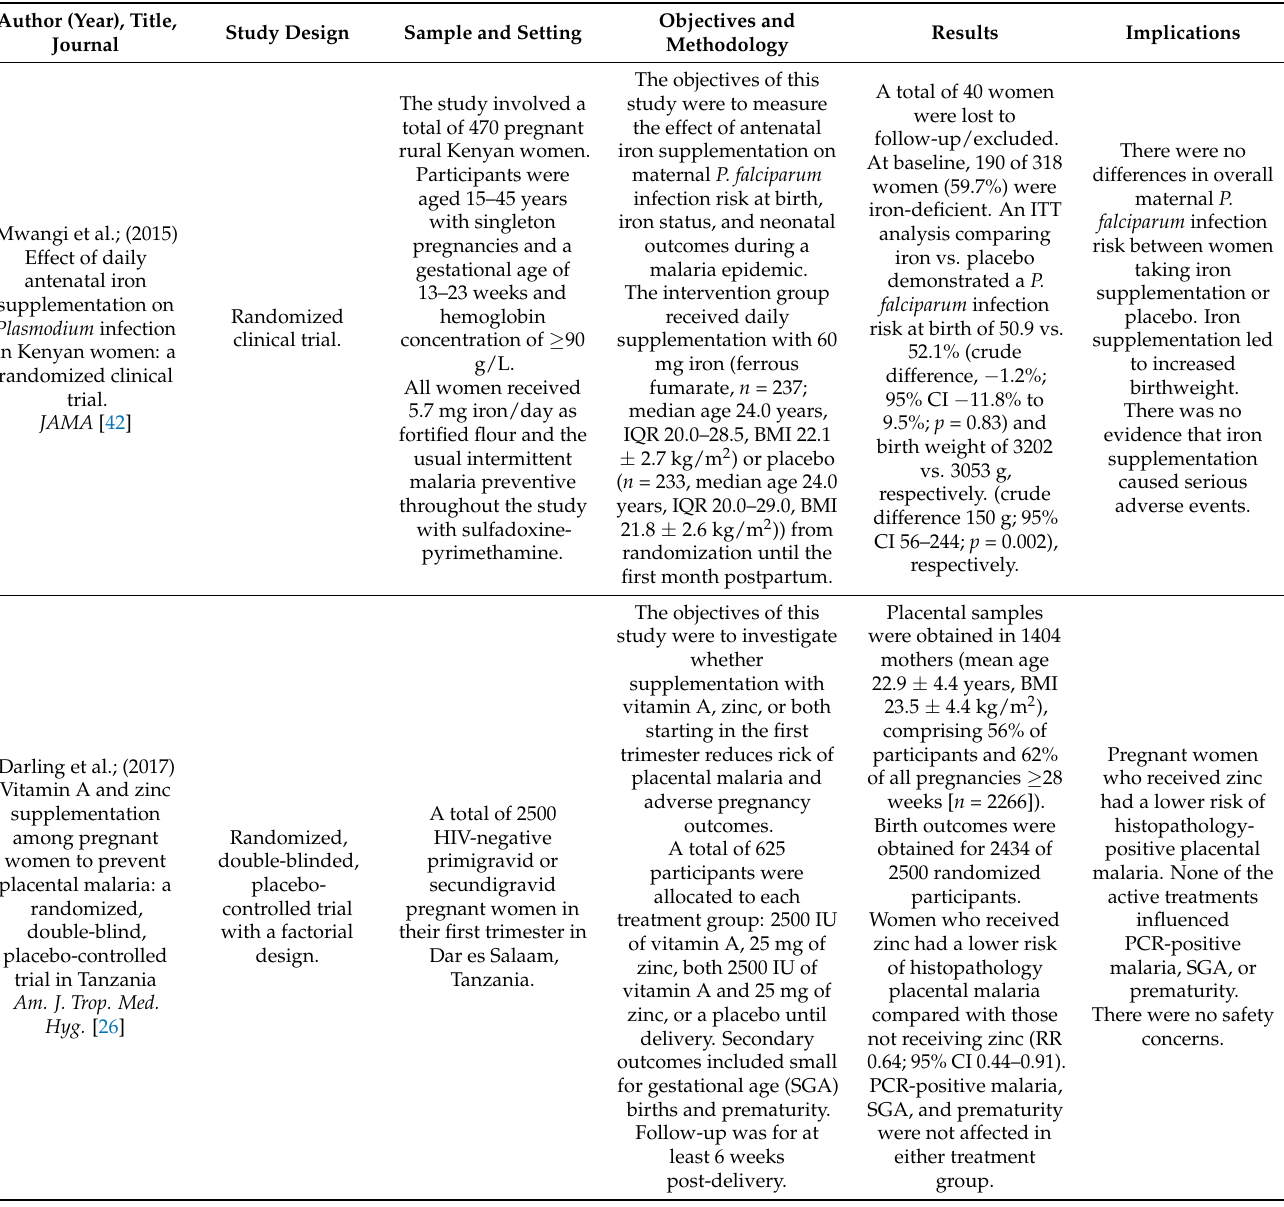
Table 4. Micronutrients, malaria, and